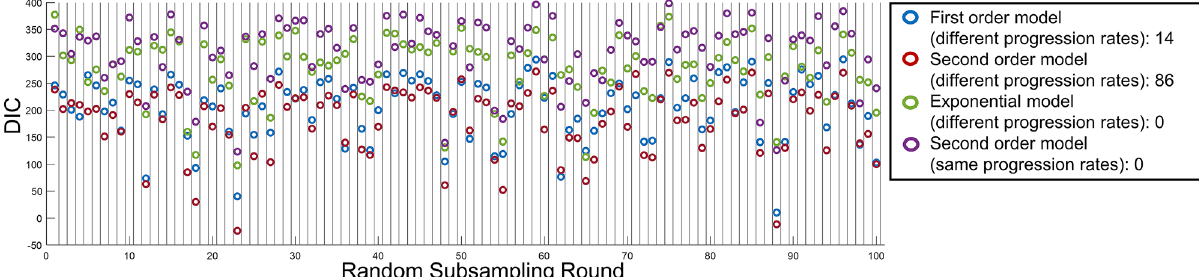
Figure 5. Comparing disease progression models based on the Bayesian entry time realignment method in 100 random subsampling of 50 patients with Huntington’s disease. The model with “different progression rates” means that the model assumes different progression rates among different patients and the model with “same progression rates” means that the model assumes the same progression rates among all patients. The number after the name of a model indicates the number of rounds when this model had the lowest